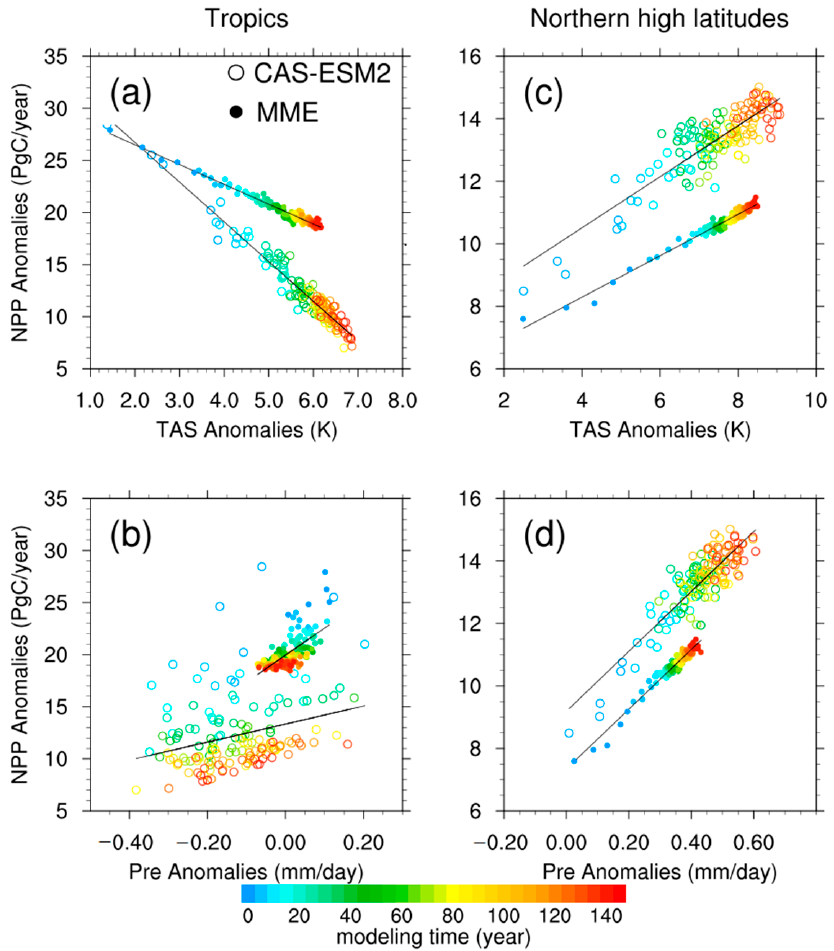
Figure 7. Scatter plots of NPP anomalies (PgC year − 1 ) with ( a ) surface air temperature anomalies (TAS; K) and ( b ) precipitation anomalies (Pre; mm day − 1 ) over tropics for the CAS-ESM2 (circled dots) and multi-model ensemble (MME; solid dots). Each dot represents a value in each year of the 149-year simulation, and their colors change from cool to warm ones with modeling time. The lines represent their linear regression relationships. ( c , d ) are the same as ( a , b ) but for northern high latitudes.